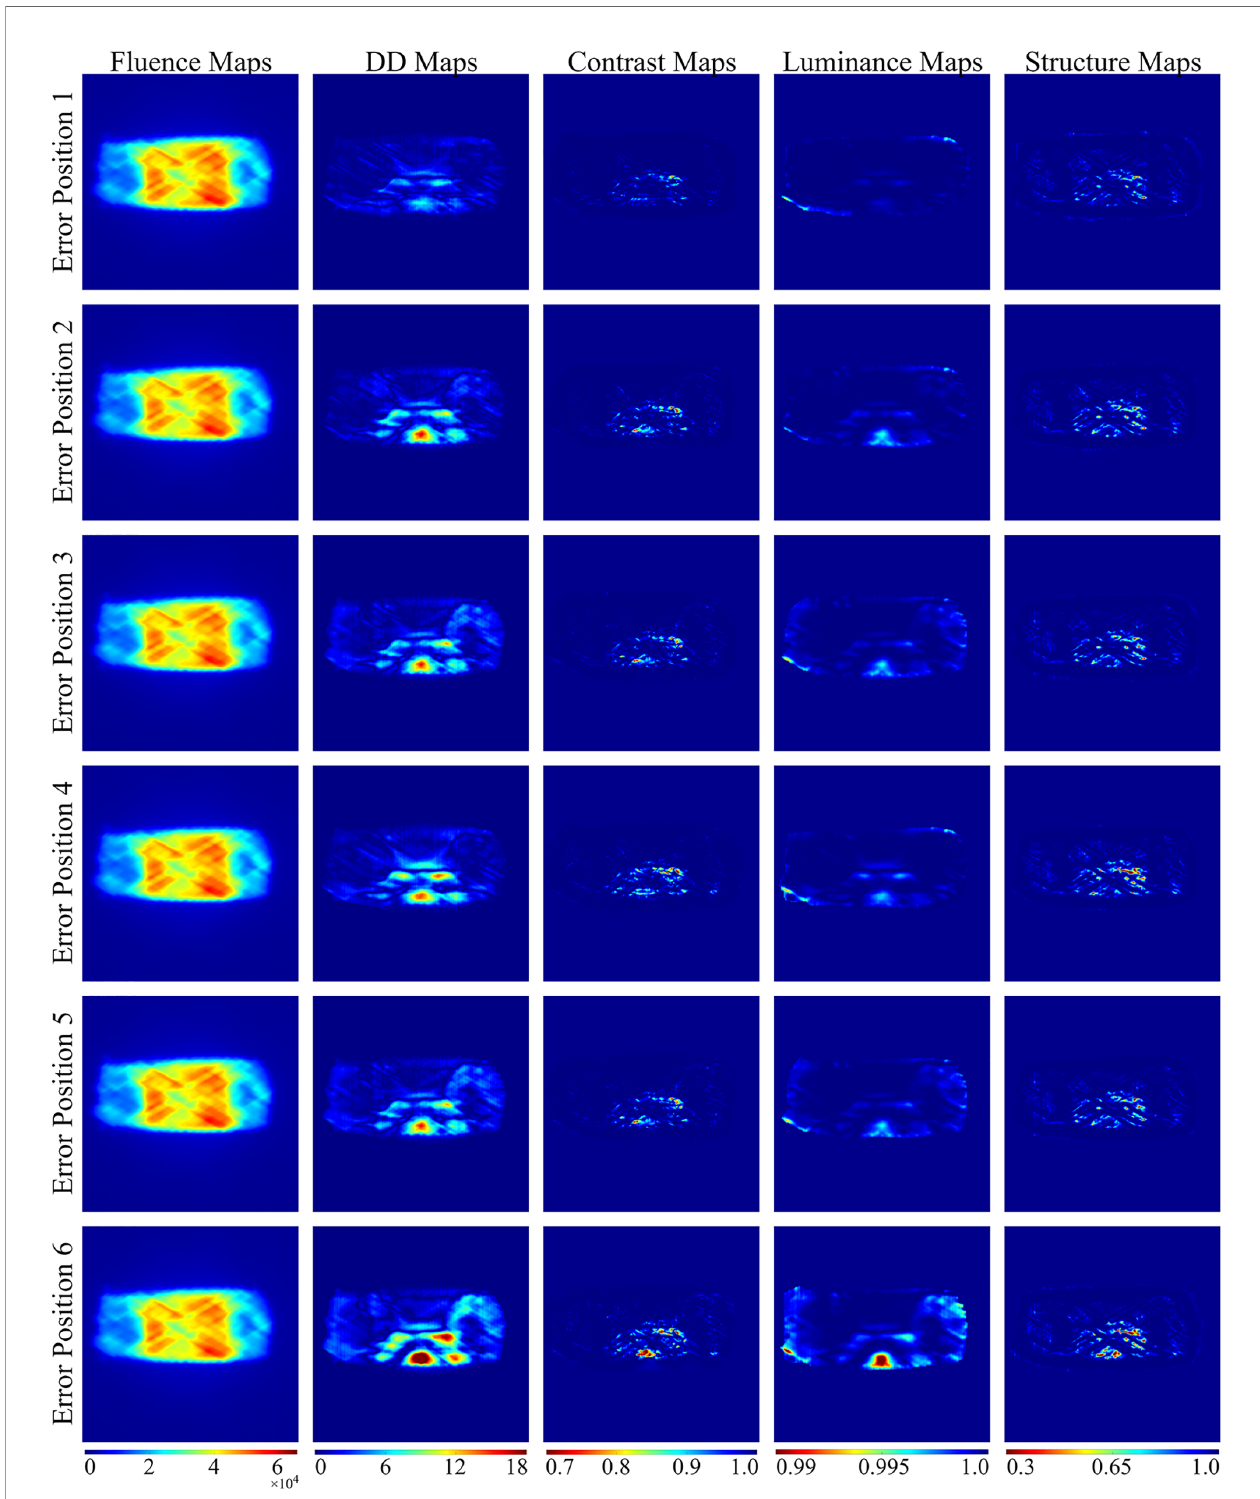
FIGURE 2 | Overview of the fl uence maps, calculated DD, contrast, luminance, and structure maps with six possibilities of error position for one patient. Error position 1 represents position with 2 mm SI errors; error position 2 represents position with 2 mm AP errors and 2 mm SI errors; error position 3 represents position with 2 mm LR errors, 2 mm AP errors, and 2 mm SI errors; error position 4 represents position with 4 mm SI errors; error position 5 represents position with 4 mm AP errors and 4 mm SI errors; error position 6 represents position with 4 mm LR errors, 4 mm AP errors, and 4 mm SI errors.